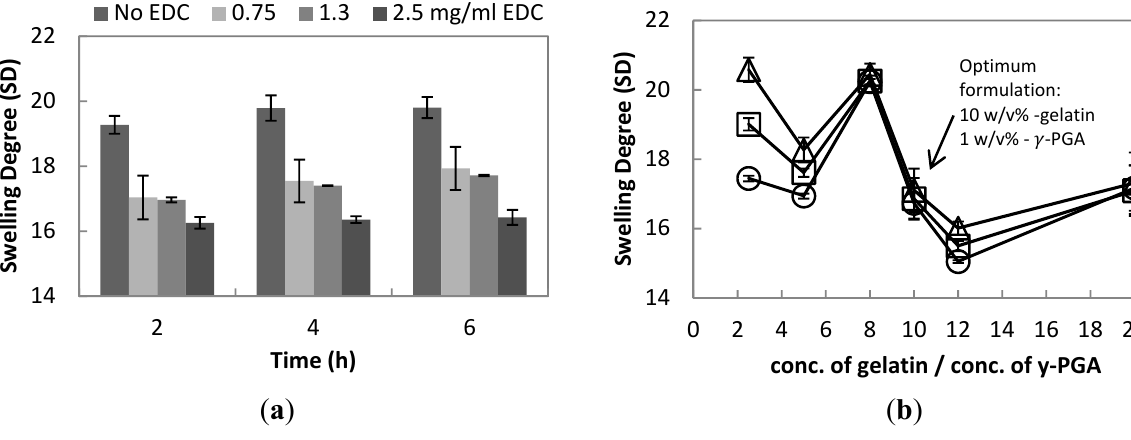
Figure 3. ( a ) The effect of increasing concentration of EDC (zero, 0.75, 1.3 and 2.5 mg/mL) to the swelling degree (SD) of hydrogel at a constant gelatin concentration of 10 w/v% and γ -PGA of 1 w/v%, swelled in PBS (pH = 7.4) for 6 h; ( b ) The swelling degree of hydrogel with a constant EDC of 1.3 mg/mL in PBS (pH = 7.4) of different ratios of gelatin (eight, 10 and 12 w/v%) over γ -PGA (0.5, one, two and 4 w/v%) (- ○ -, 2 h; - □ -, 4 h; - ∆ -, 6 h of